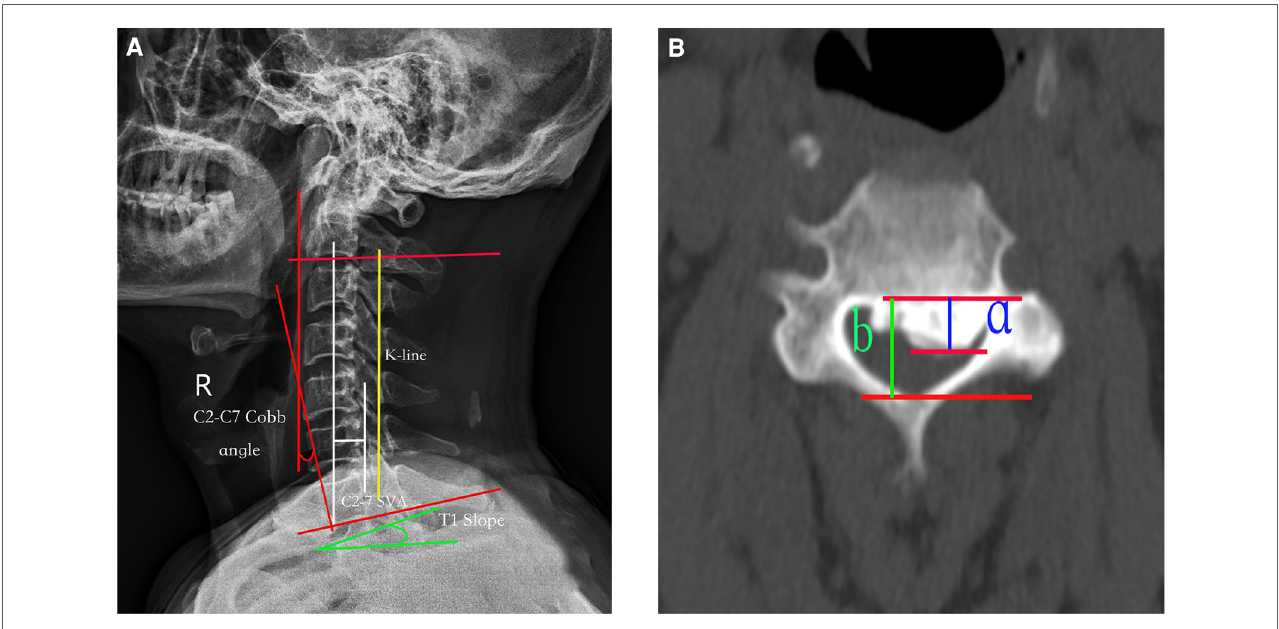
FIGURE 1 ( A ) Radiographic measurements: (1) the K-line is a straight line joining the midpoints of the spinal canal at C2 and C7 on a lateral radiograph; (2) C2 – C7 SVA: the distance between the C2 plumb line and the superoposterior endplate of C7; (3) C2 – C7 Cobb angle: the angle formed by the C2 and C7 lower endplates; and (4) T1 slope: the angle between the horizontal line and the T1 upper endplate. ( B ) Percentage of spinal canal occupation by ossi fi ed mass. The thickness of the ossi fi cation block (a, green line) and the anteroposterior diameter of the spinal canal (b, yellow line) were measured on the axial CT section of the highest point of the ossi fi cation block. The percentage of spinal canal occupation by the ossi fi cation block=a/b×100%. SVA, sagittal vertical